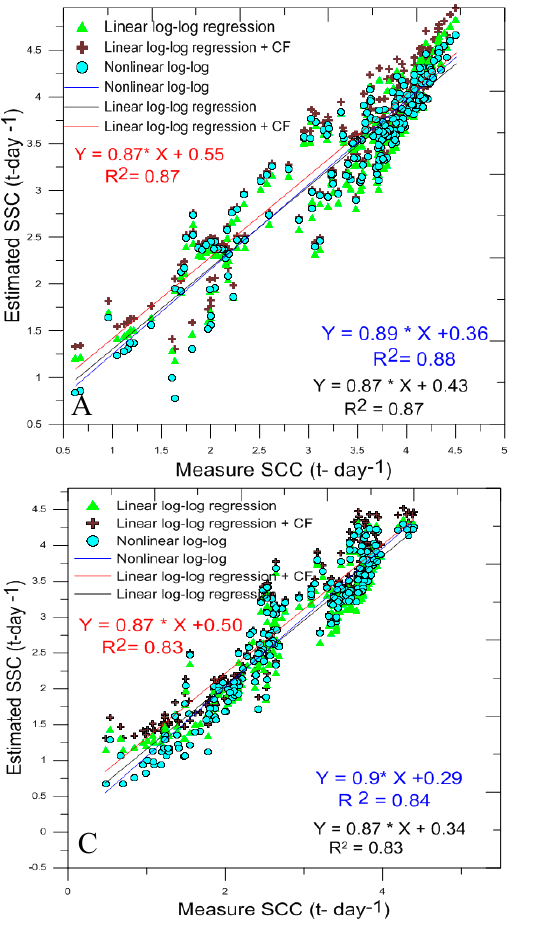
Figure 7. Predicted and observed SSCs at station ( A ) Duguda; ( B ) Maki; ( C ) Abura; and ( D ) Fite. Similarly, for the lake outlet station (Bulbula River), the sediment rating curve was developed as shown in Figure 8A by using Equations (1), (2), and (4), and the comparison plot between measured and computed data is shown in Figure 8B.